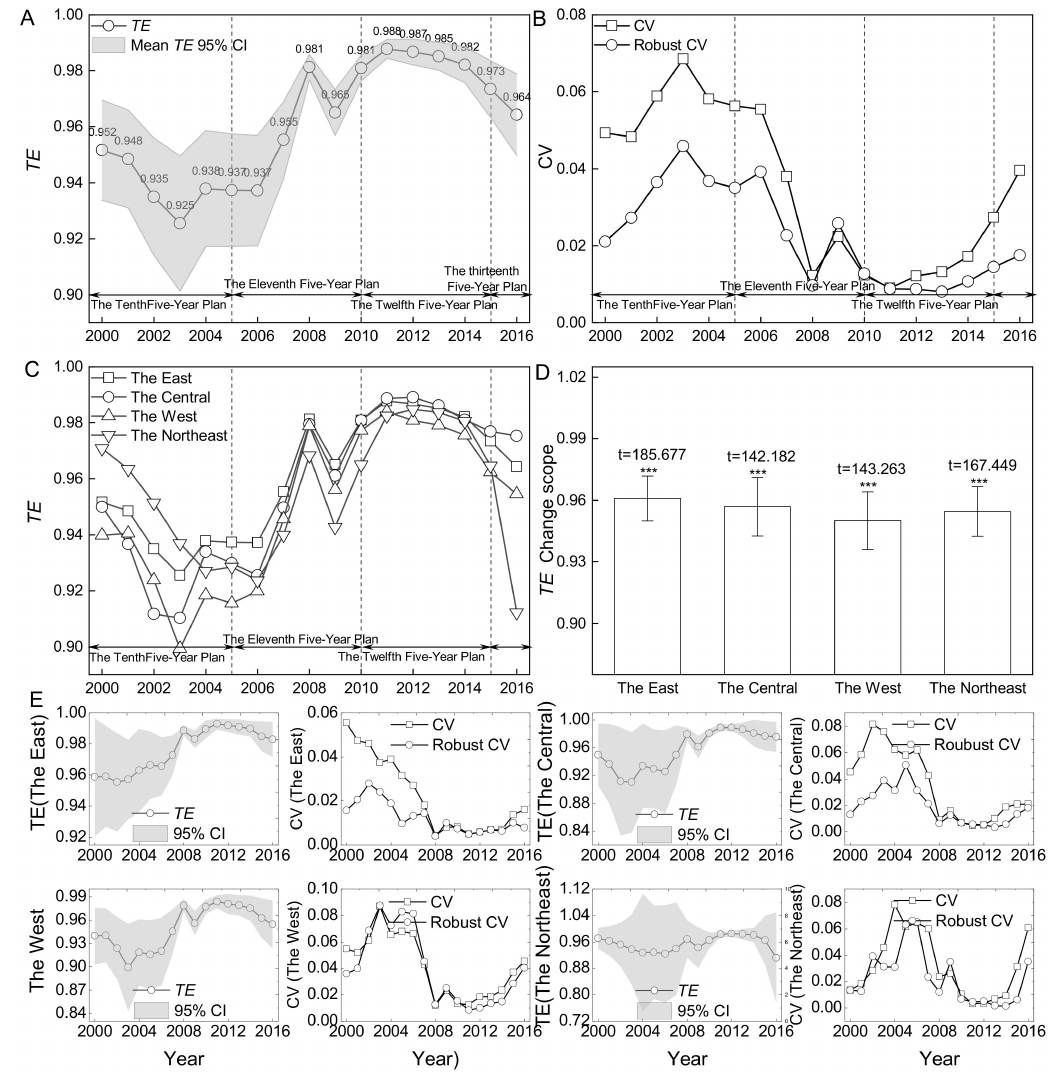
Figure 1. Annual mean trend and coefficient of variation of energy TE under the influence of factor distortion and carbon dioxide emissions. Note: CI 95% is 95% confidence interval; ( A ) China energy industrial chain technology efficiency annual change trend and 95% confidence interval; ( B ) China energy industrial chain technology efficiency annual average coefficient of variation and robust coefficient of variation trend; ( C ) China eastern, central, western and northeast energy industrial chain technology efficiency annual change trend; ( D ) China eastern, central, western and northeast mean one-sided t -test and 95% error analysis; ( E ) the coefficient of variation, robust coefficient of variation and 95% confidence interval of TE in different regions. *** means the t -test value pass the statistical